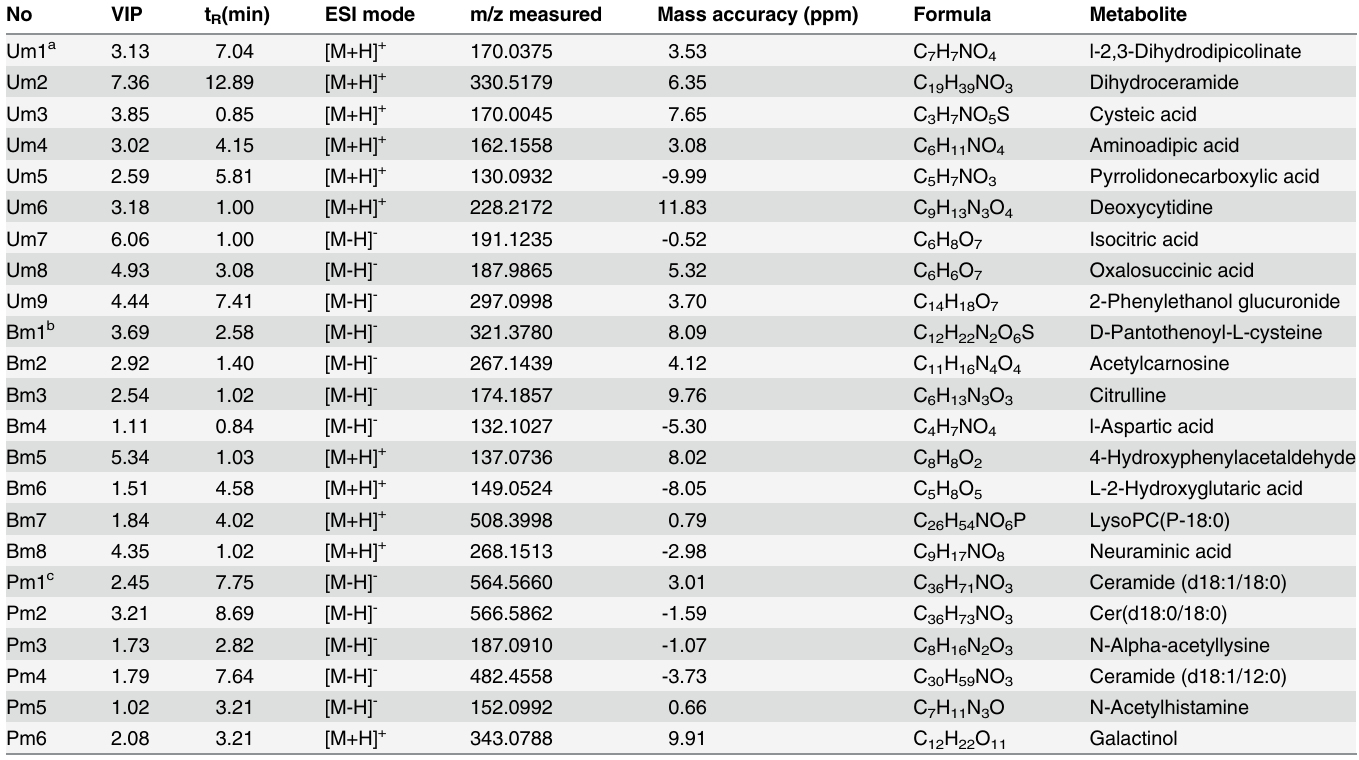
Table 4. UPLC-MS identification of potential